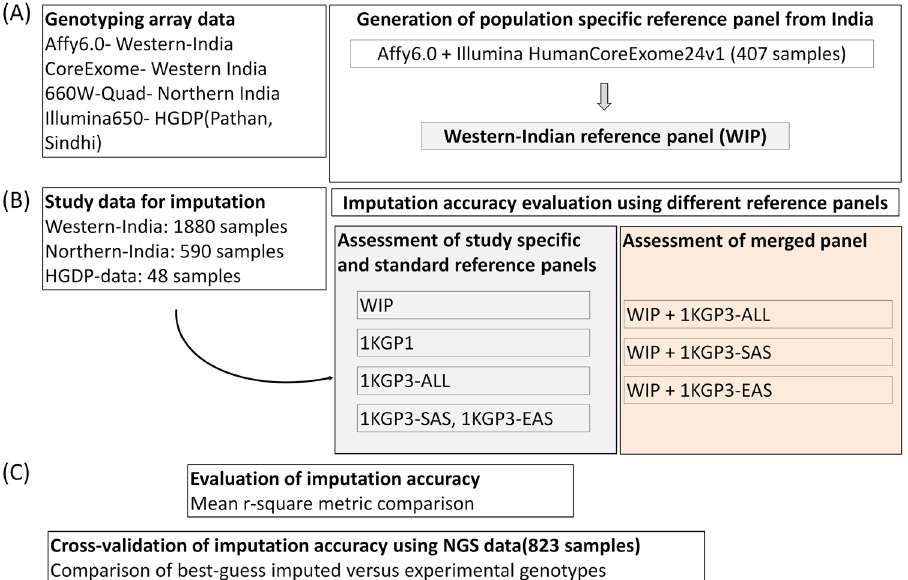
Figure 1. Schematic representation of the study design and analyses. Affy6.0 and Illumina HumanCoreExome data on 407 overlapping individuals from Western India was merged and used to generate the Western-Indian Reference Panel (WIP). SNPs from the Affy6.0 data on 1880 Western Indians, Human660W-Quad array data on 590 subjects from Northern India and HGDP data using Illumina 650K array on 48 Pathan and Sindhi subjects were imputed using different reference panels. The imputation accuracy was compared using r-square metric. Finally, cross-validation of imputation accuracy was performed on 823 samples having genotype data from HiSeq platform for the 3.57 Mb region and their imputed counterparts (imputed for Affy6.0 data). 1KGP1, The 1000 Genomes phase 1 panel; 1KGP3-ALL, The 1000 Genomes phase 3 panel with all 2504 samples; 1KGP3- SAS, The 1000 Genomes phase 3 panel with only South Asian component; 1KGP3-EAS, The 1000 Genomes phase 3 panel with only East Asian component; WIP + 1KGP3-ALL, merged panel of WIP and 1KGP3-ALL; WIP + 1KGP3-SAS, merged panel of WIP and 1KGP3-SAS; WIP + 1KGP3-EAS, merged panel of WIP and